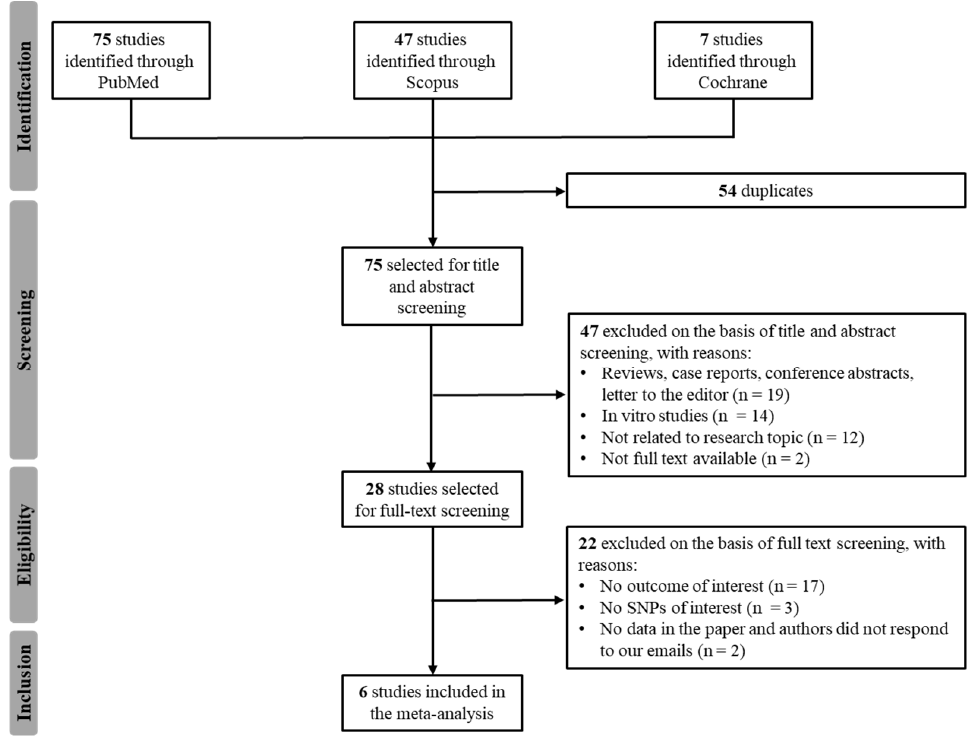
Figure 1. Flowchart of the literature review process.